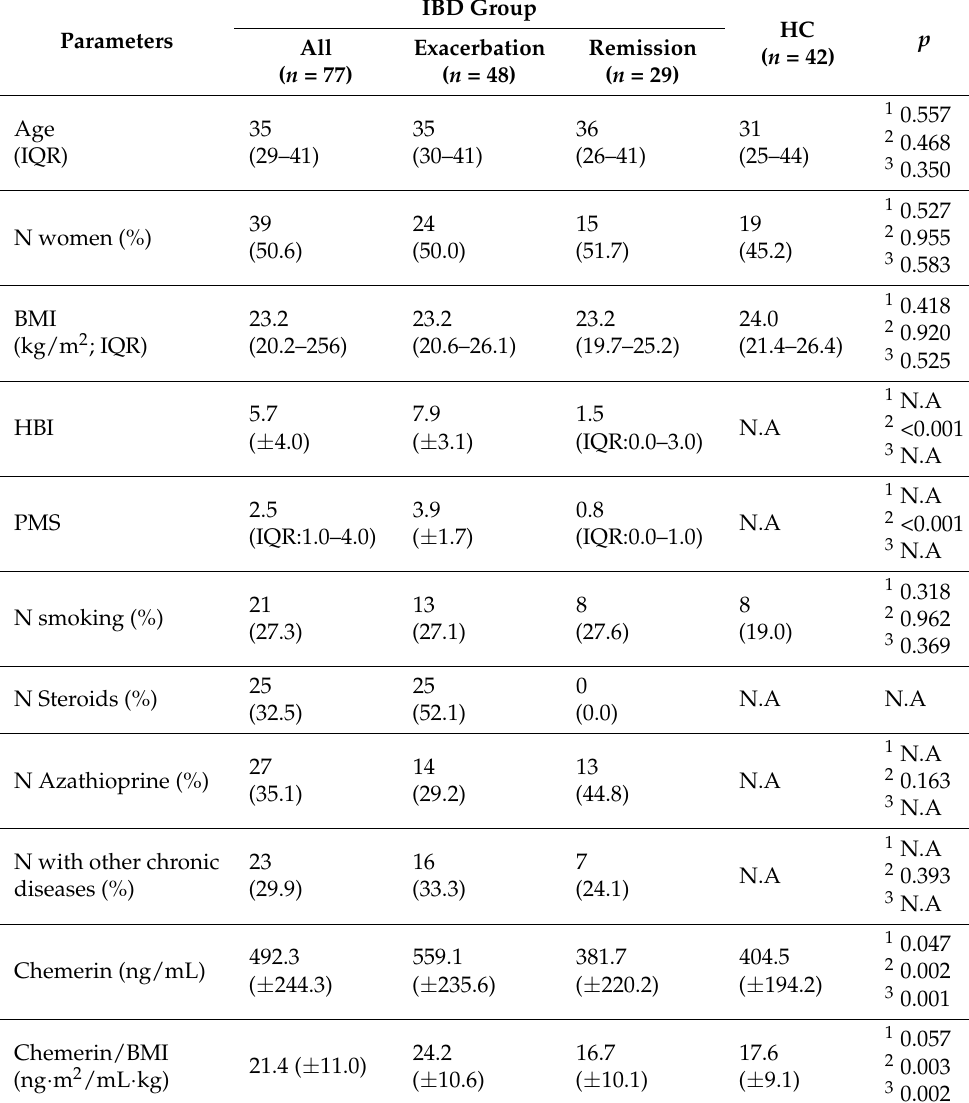
Table 1. General characteristics of the study participants and the results of serum chemerin concen-